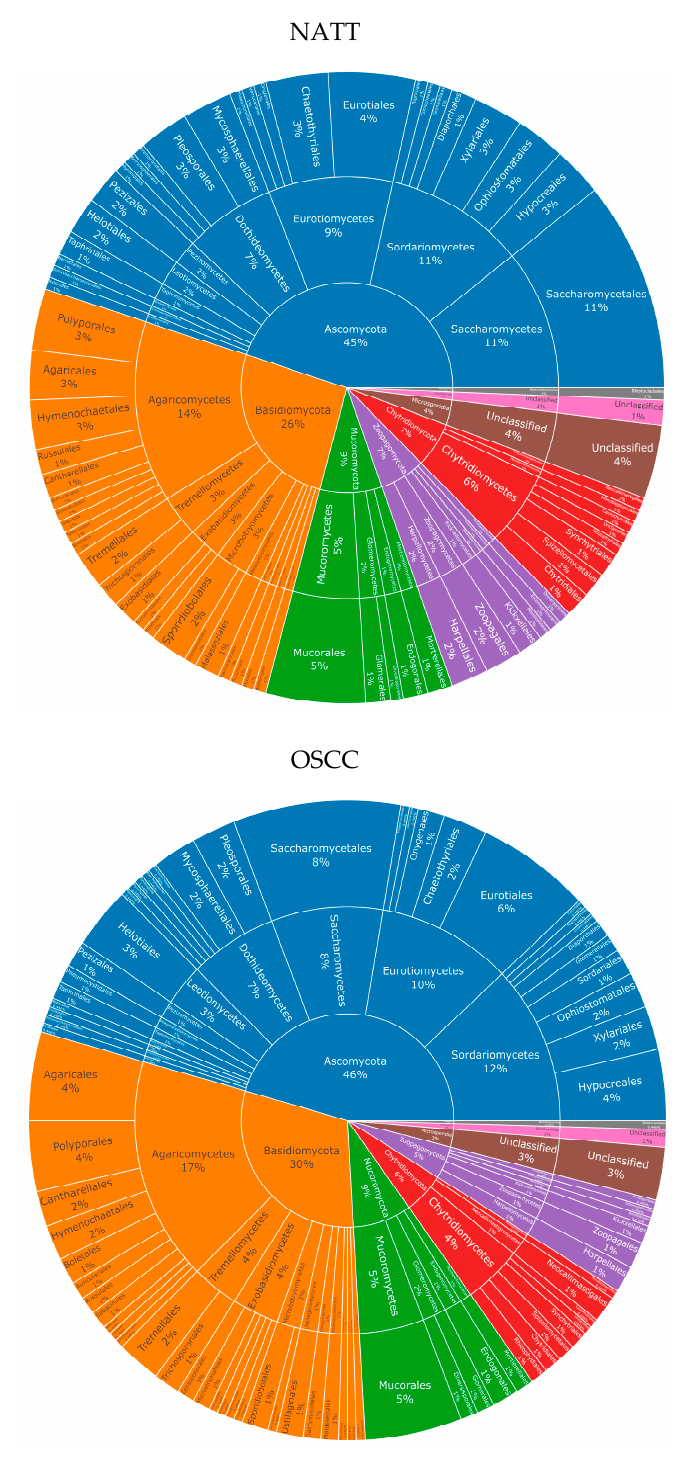
Figure 2. Fungal taxonomy in NAT and OSCC patient samples: Sunburst plots showing inferred fungal composition in NAT (top) and OSCC (bottom) patient samples. Classification level from inner to outermost radials: Phylum, Class, Order. Colours represent species’ phylum, while percentage values represent proportion within a given classification level. Taxonomic sunburst plots for bacterial and viral species can be viewed in Supplementary Figures S1 and S2. List of all species can be viewed in Supplementary File S2.